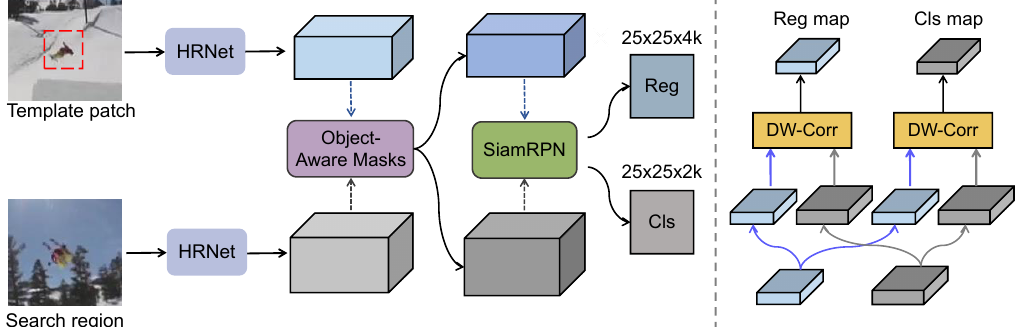
Figure 1. The overall tracking framework of the proposed HROM. The ( left ) figure illustrates our main structure, while the ( right ) one shows the RPN head in